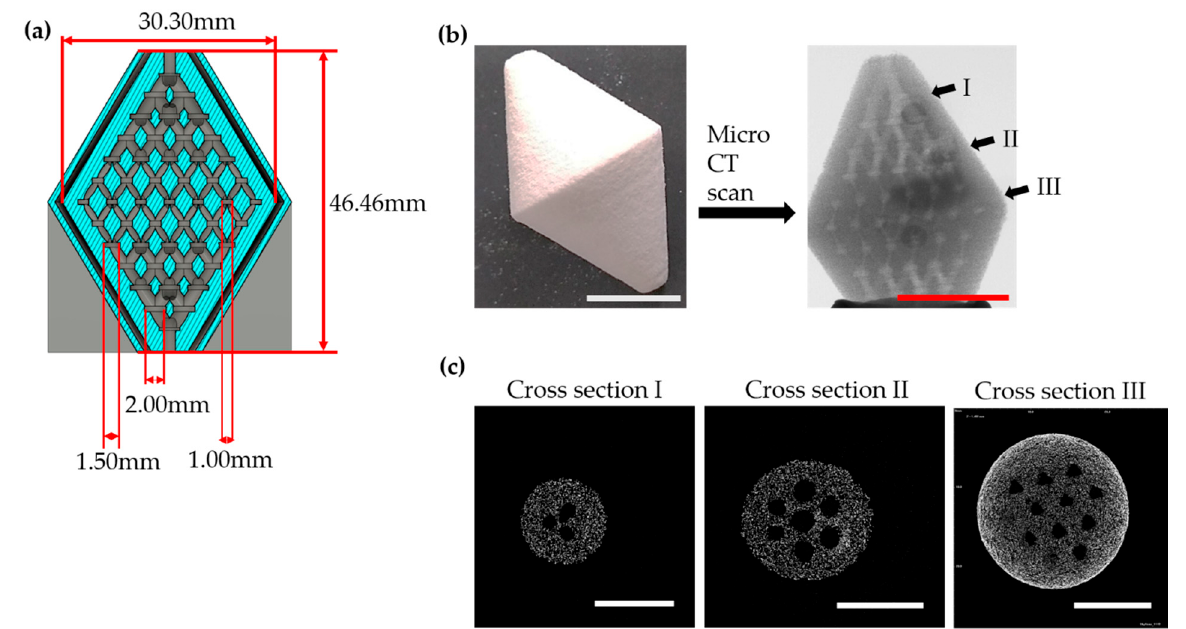
Figure 2. ( a ) Computer aided design (CAD) model and dimension of the 3-D scaffold; ( b ) fabricated three-dimensional scaffolds after selective laser sintering (SLS) printing and micro-CT scan. The scale bars are 10 mm. (i) Slices from different layers of the scaffold with internal diameters of the channel of 2 mm (ii), 1.5 mm (iii), and 1 mm (iv); ( c ) cross section of the internal diameter of interconnected channel (scale bar 10 mm, magnification 5×. The slices of cross section I (approximately channel diameter 2 mm), cross section II (approximately channel diameter 1.5 mm), and cross section III (approximately channel diameter 1 mm) was sliced from region I, II, and III as depicted in ( b ).